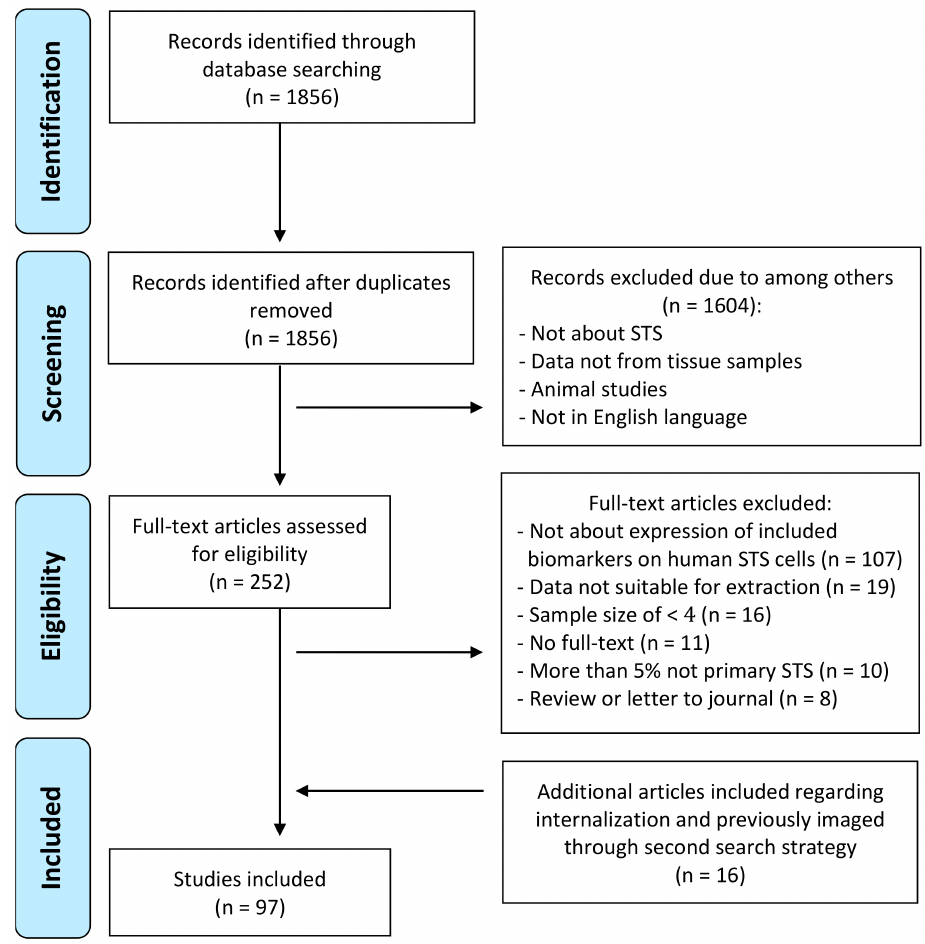
Figure 1. Flowchart of study selection